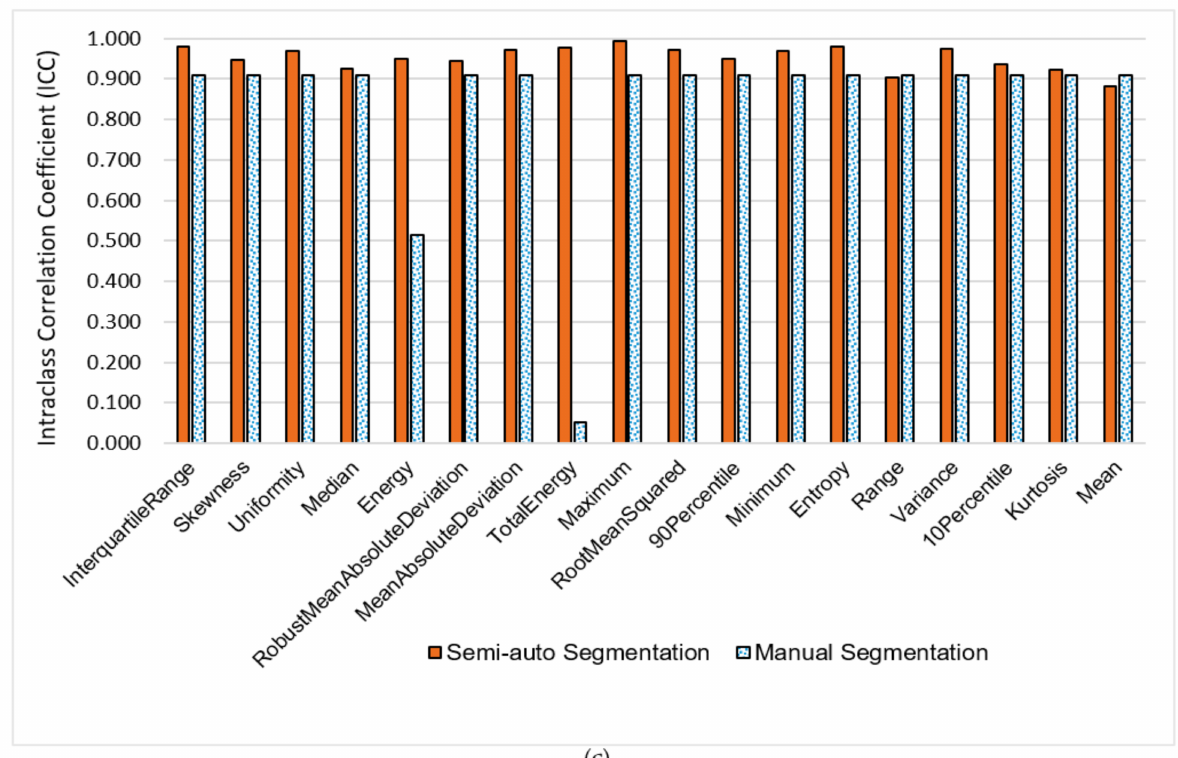
Figure 2. Comparisons of intra-class correlation coefficient (ICC) values in ( a ) shape based features, ( b ) textural features, and ( c ) first order statistics